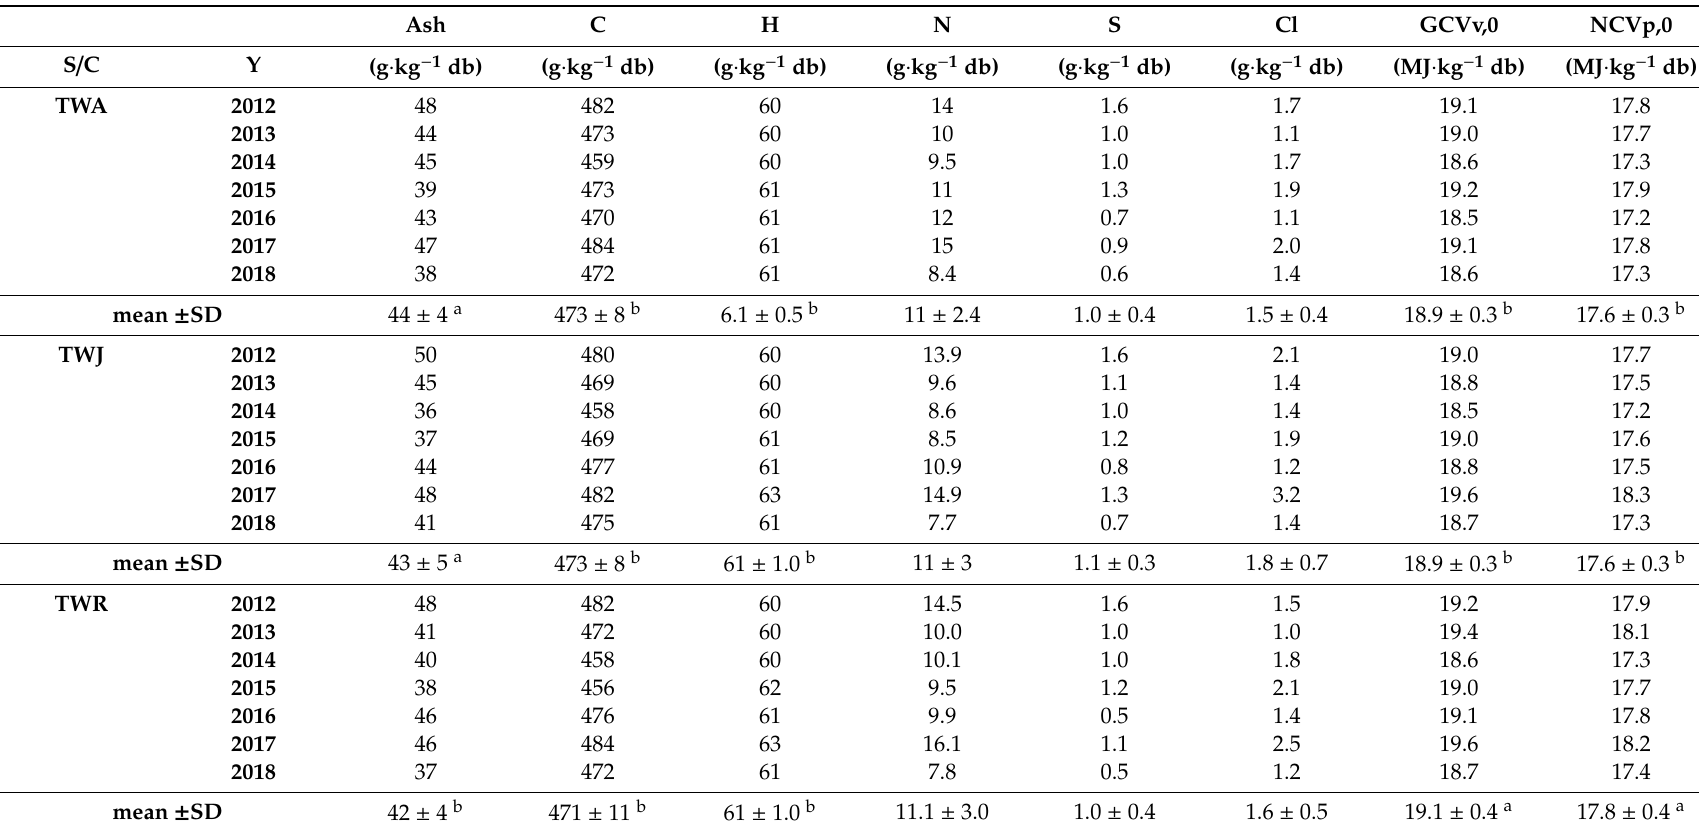
Table 6. Ash content, calorific values, and ultimate analysis of the biomass of di ff erent perennial grasses collected between 2012 and 2018 at CS plots. Mean values for three replicate plots per species, cultivar, and